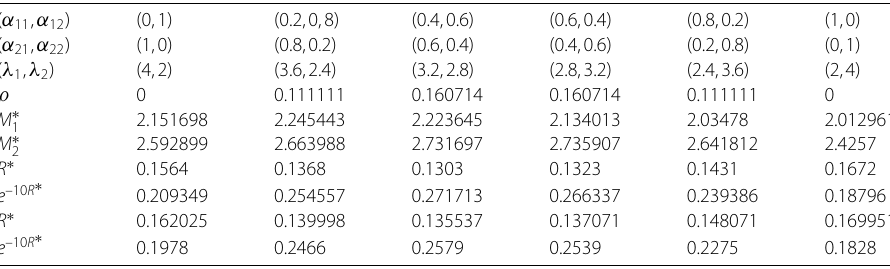
Table 4 Comparison of Lundberg exponent: exponential case. ( θ 1 , θ R ( θ 2 , θ R ) = (0.25,0.5), values of Lundberg exponent and upper bound of ruin probability with different 2 dependence parameters for Hu’s model and our